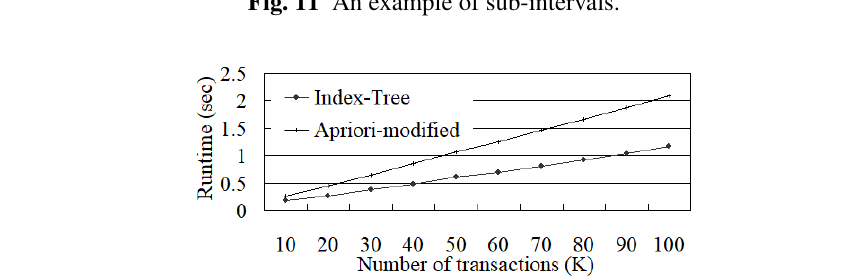
Fig. 11 An example of sub-intervals.